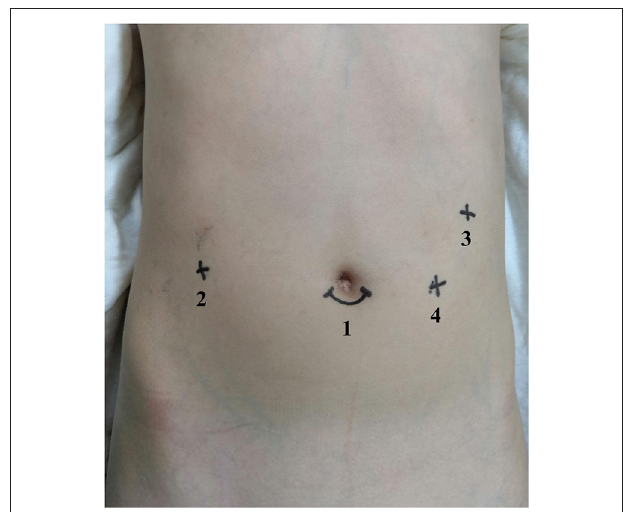
FIGURE 1 | Port placement in robot-assisted surgery for choledochal cysts. (1) Camera port. (2) Port I. (3) Port II. (4) Assistant